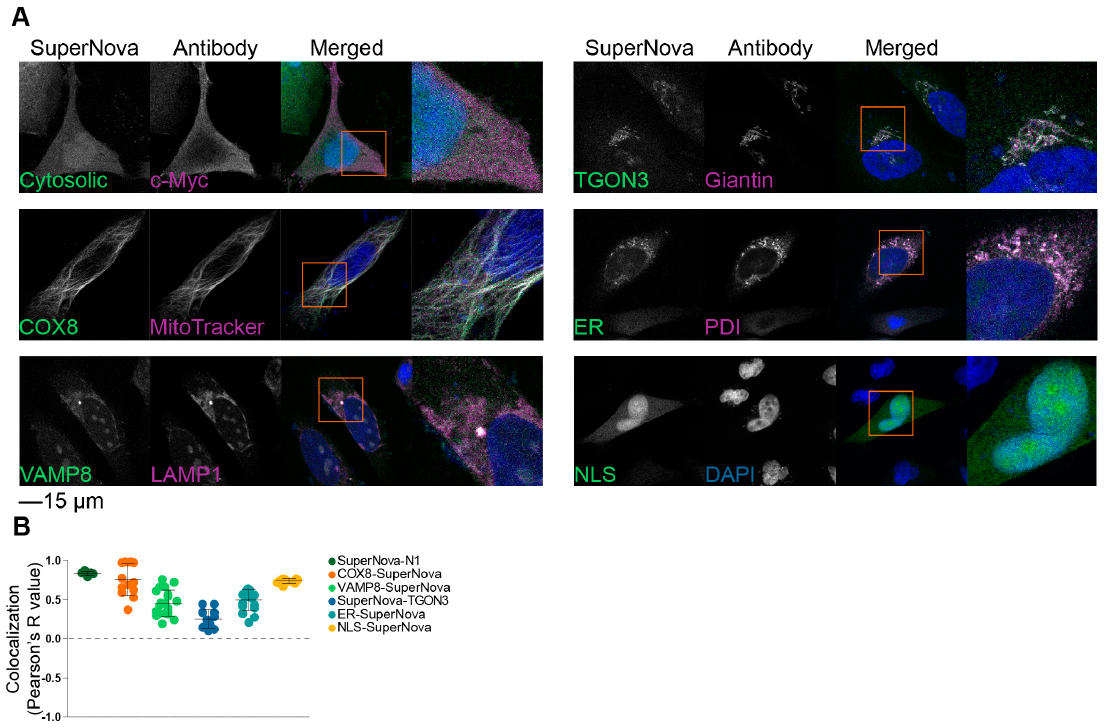
Figure 2. Localization of SuperNova fusion constructs. ( A ) Representative confocal images of HeLa cells transfected with constructs encoding for SuperNova fusion proteins with appropriate counter stains for the target organelles. DAPI is in blue. Cytosolic: SuperNova-N1. Scale bar: 15 µ m. ( B ) Pearson’s colocalization coe ffi cients of the SuperNova fusion proteins with the organellar markers from panel A . Three technical repeats, each dot represents a microscopy image.